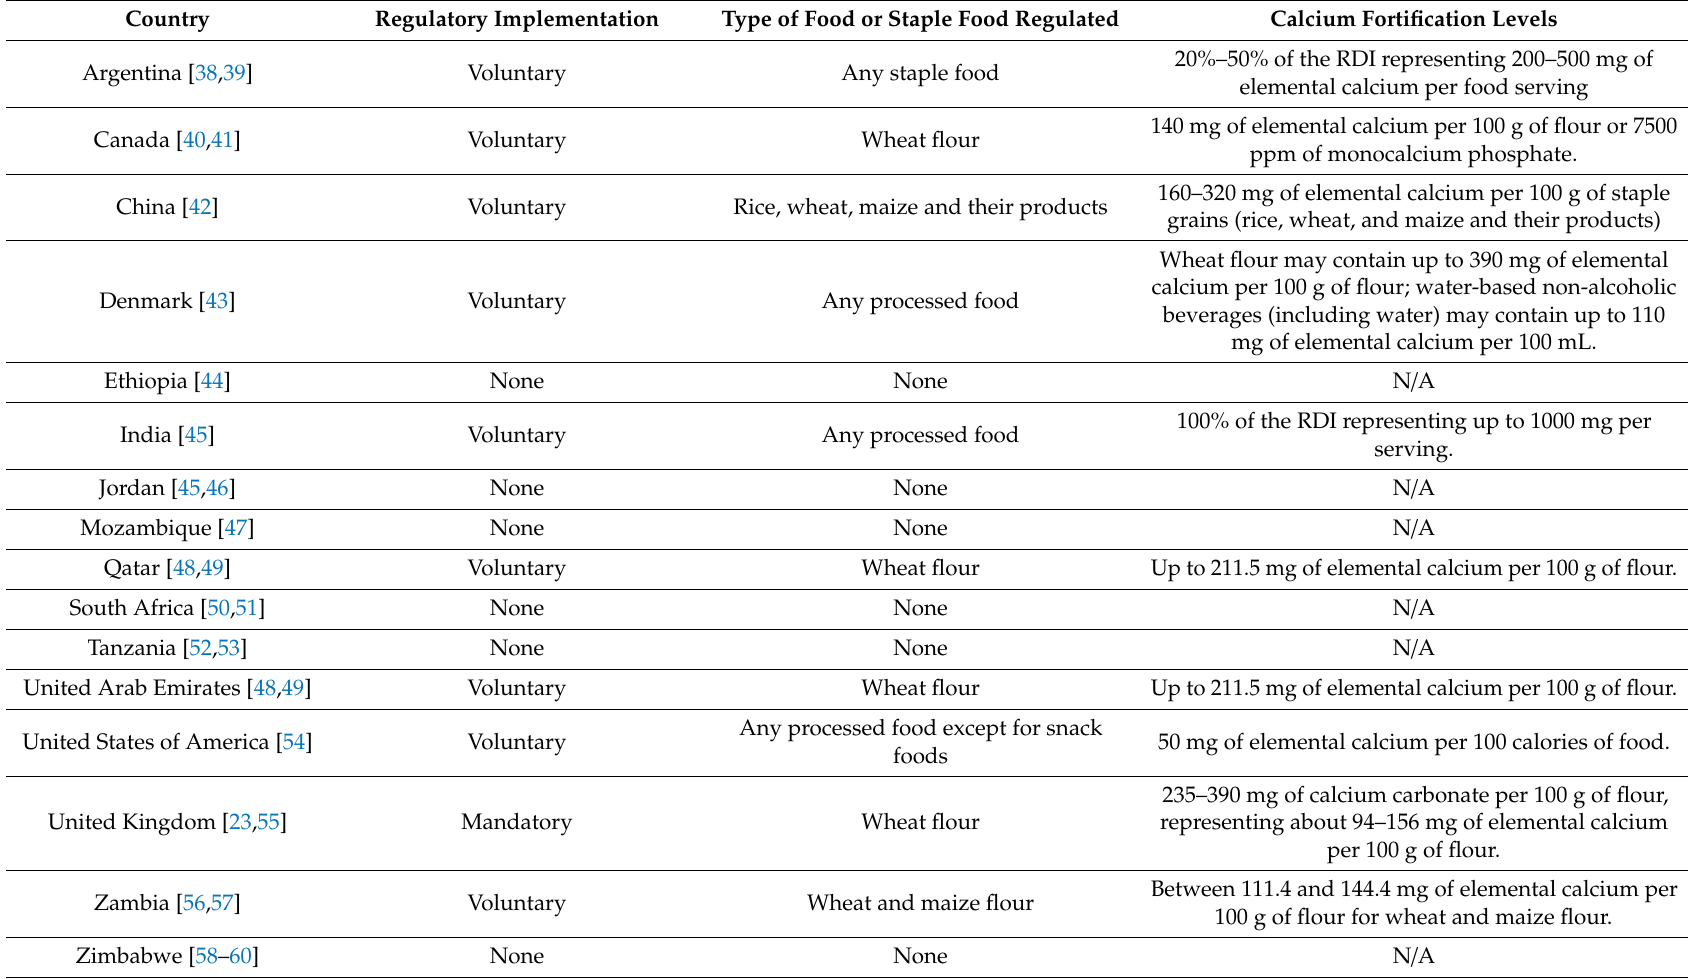
Table 1. Summary of regulations for calcium fortification of staple foods in countries of interest with notes on other fortification